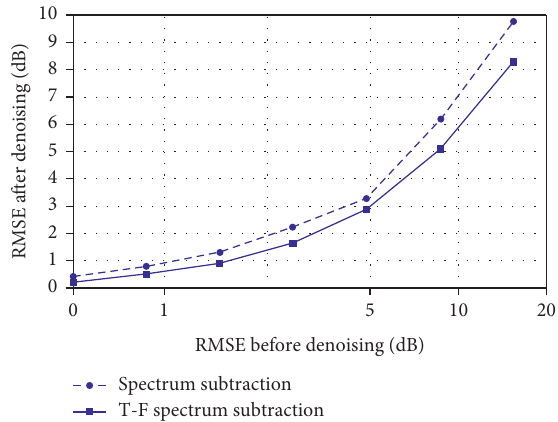
Figure 11: Comparison of RMSE of the sigmoid model before and after denoising.